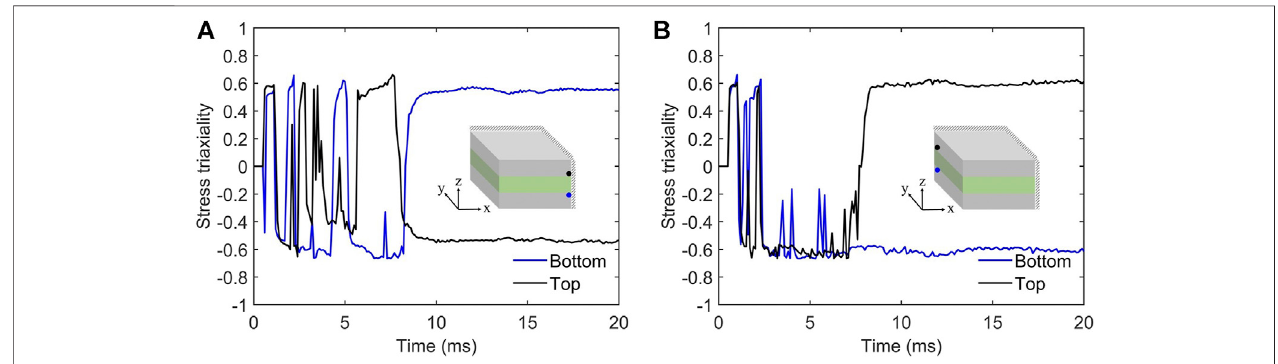
FIGURE 7 | The evolution of stress triaxiality of the 0.22/0.36 [0 ° /0 ° ]/0.22 plate under the impulsive load of Z (cid:2) 1 . 82 m / kg 1 / 3 at (A) the mid-point of edge perpendicular to the fi ber direction and (B) the mid-point of edge parallel to the fi ber direction.